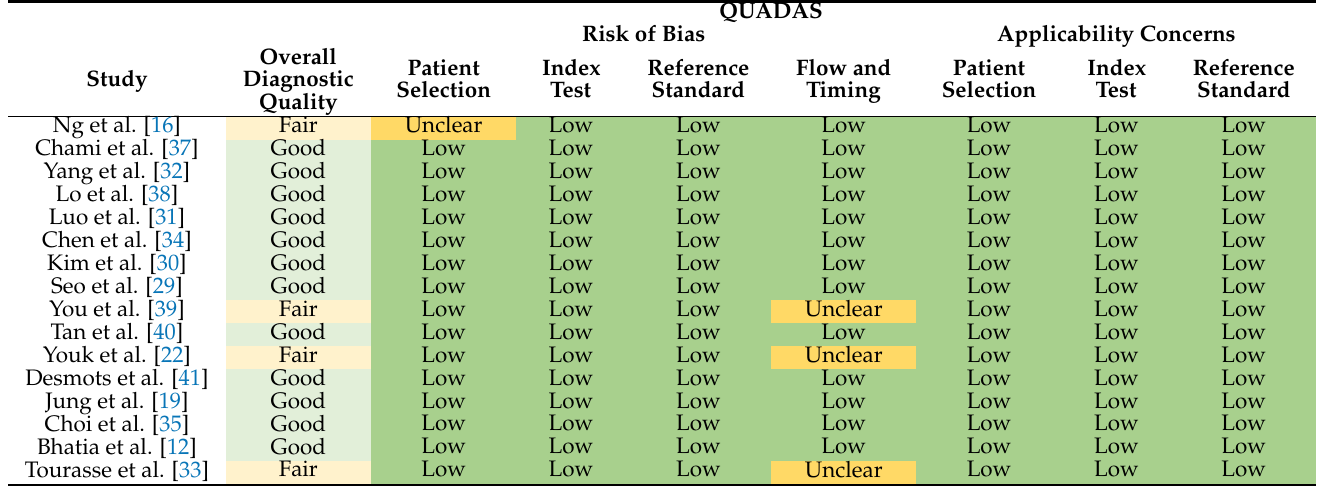
Colour representation: green indicates low risk of bias and yellow indicates unclear risk of bias.